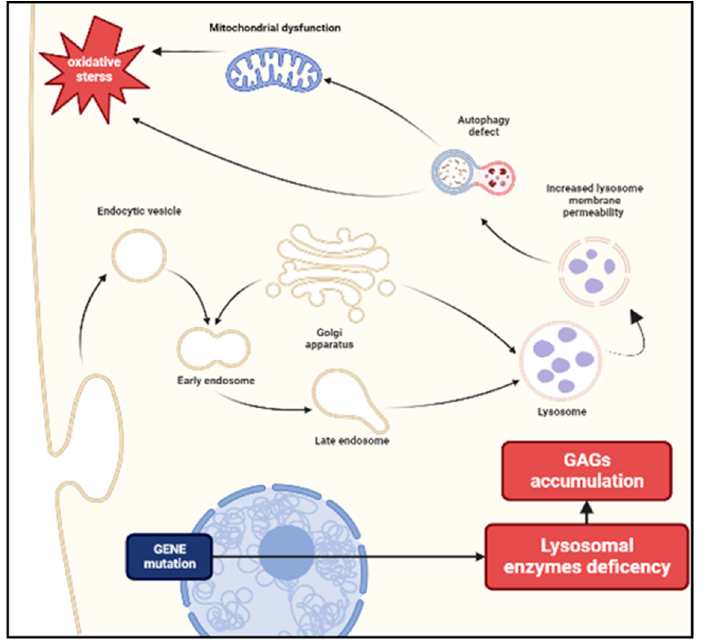
Figure 1. Pathogenesis of MPS. The deficiency of enzymes necessary for the degradation of gly- cosaminoglycans (GAGs) leads to an accumulation of these substrates in lysosomes. Increased lysosomal membrane permeability influences cellular homeostasis and causes impaired vesicular fusion and autophagy. A secondary mitochondrial dysfunction may cause a release of reactive oxygen species resulting in oxidative stress.